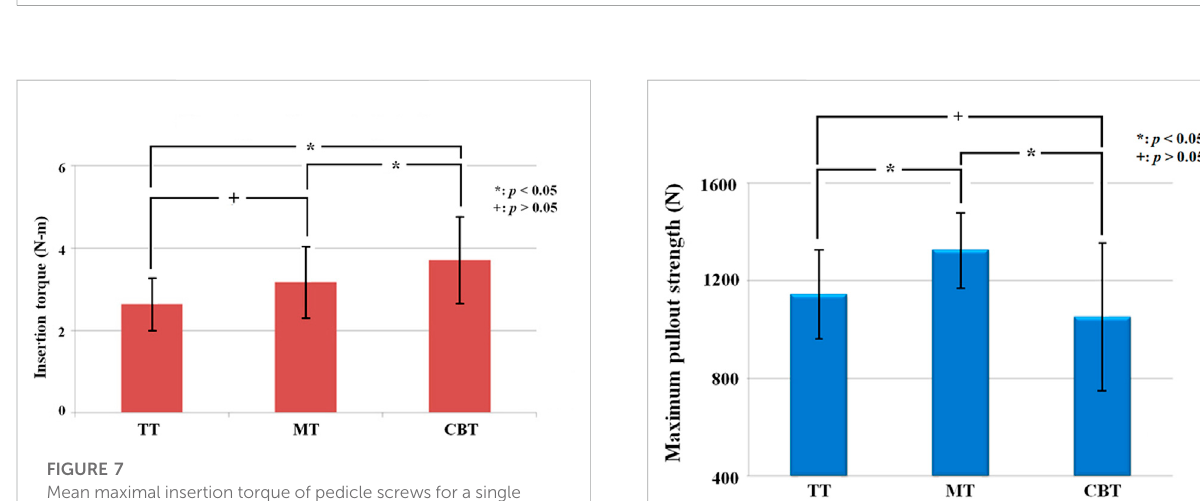
Experimental setup of the screw pullout test of FSU constructs. (A) Sagittal view and (B) axial view. A custom-made turnbuckle fi xture was used to attach the actuator to the rod.